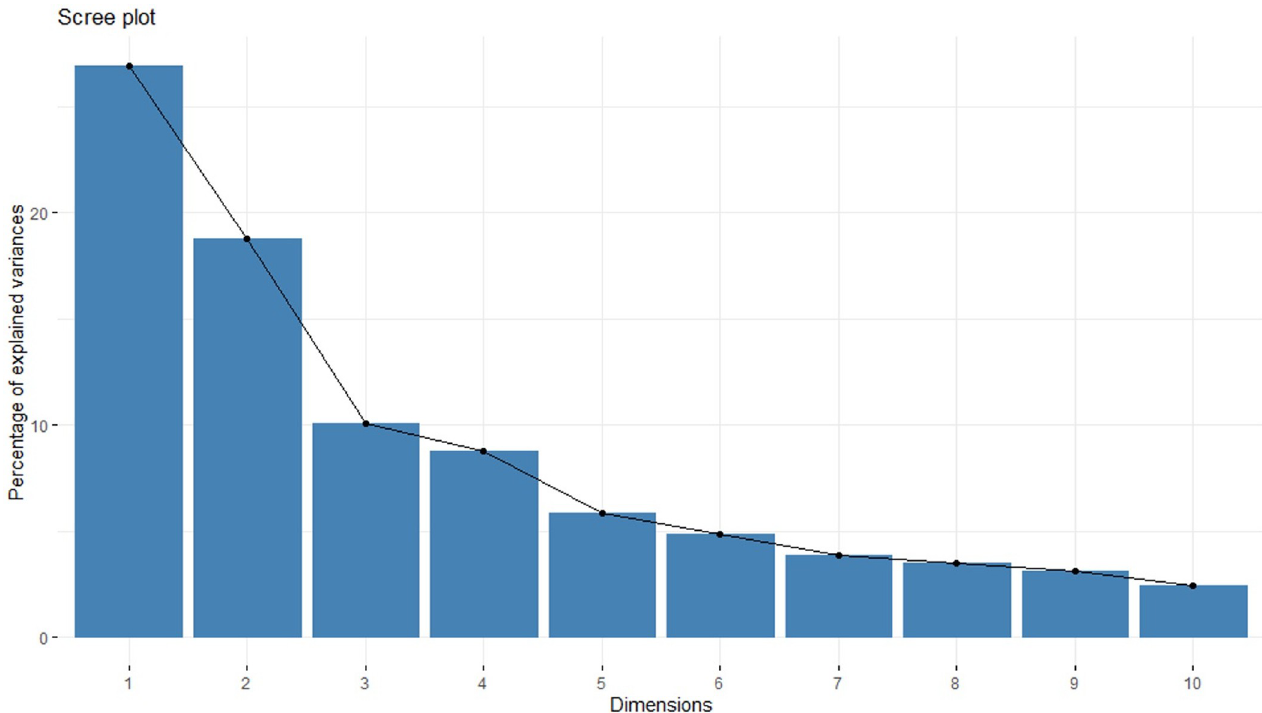
Fig 1. Scree plot of the proportion of variance explained in a principal component analysis working dog personality metrics against the corresponding components. The inflexion point suggests components beyond 3–4 would add relatively little information.